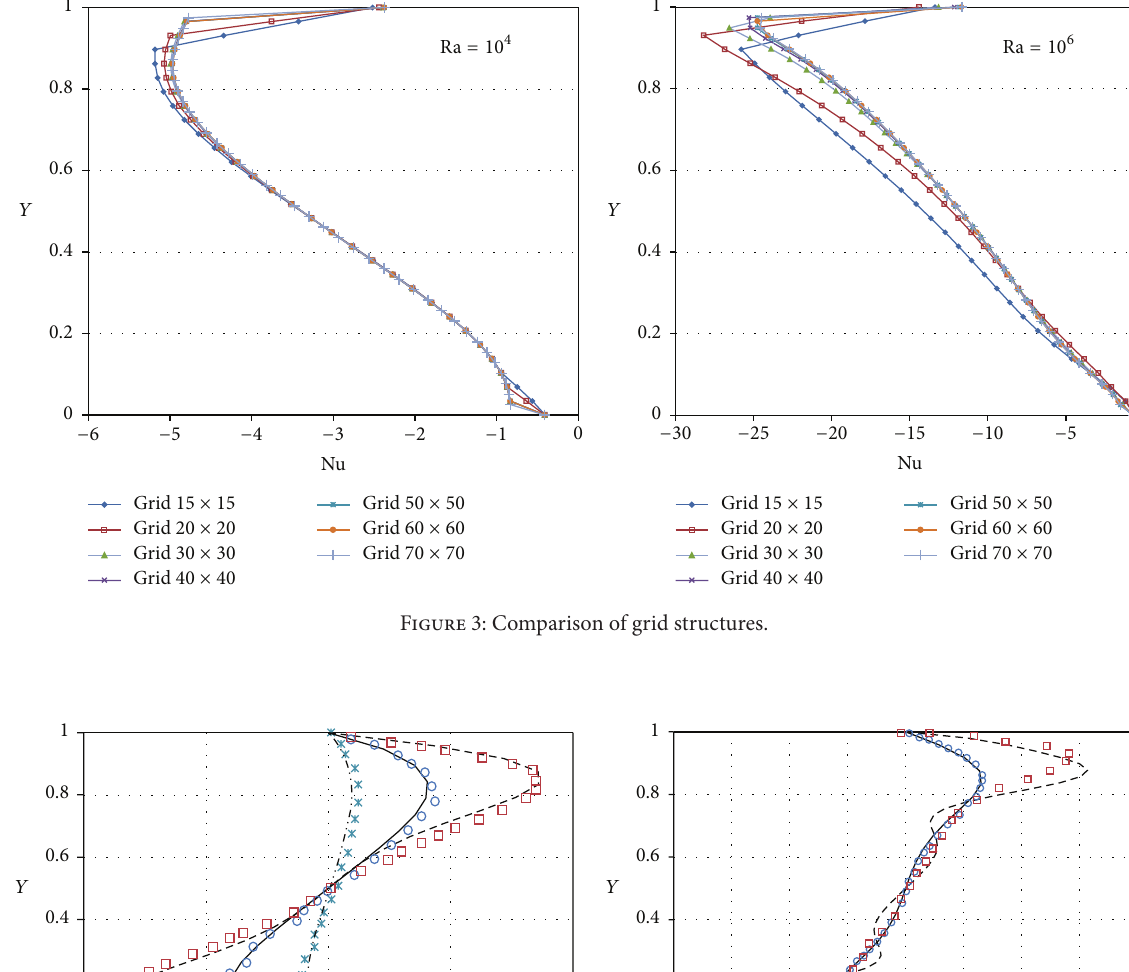
Figure 4: Comparison of horizontal velocities ( 𝑢 ) at the midwidth ( 𝑥 = 0.5